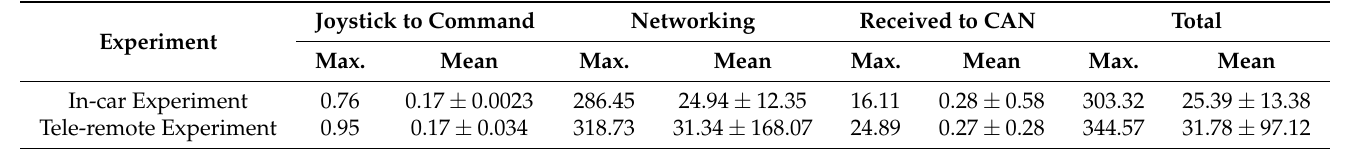
Table 2. Maximum and mean delays for the joystick commands delivery in each of the experiments. Delays expressed in ms.